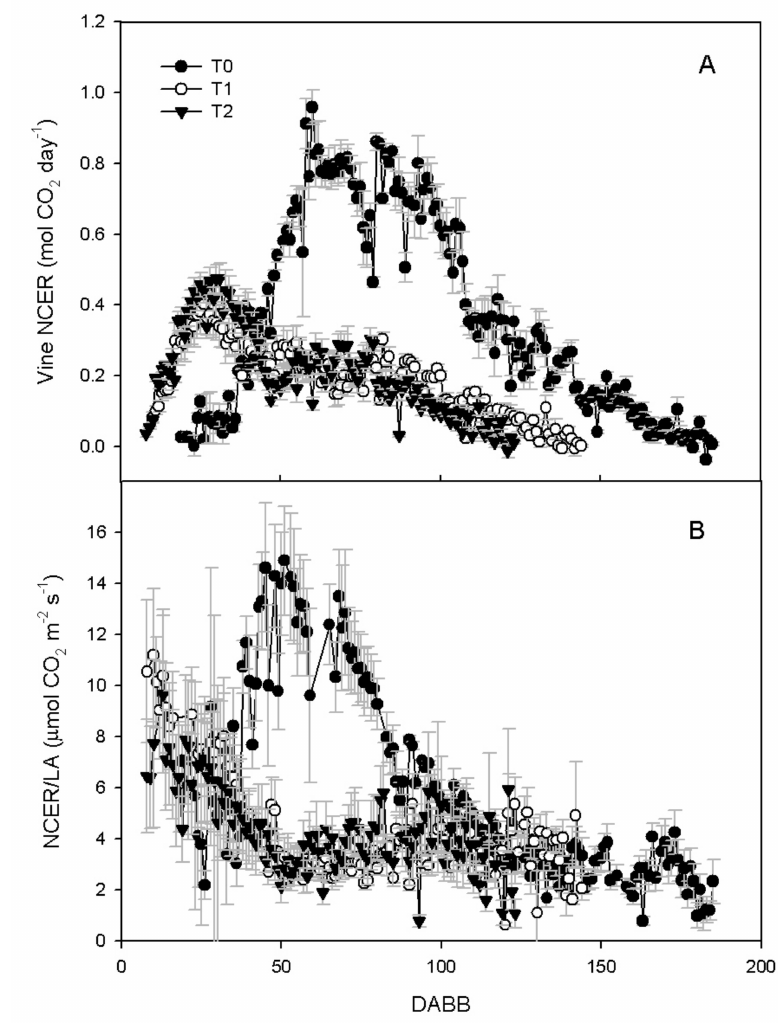
Figure 5. Vine net CO 2 exchange rate (NCER) ( A ) and daily mean leaf-specific NCER ( B ) from budburst to leaf fall vs. day after budburst (DABB) in T0, T1, and T2 vines ( n = 4). Mean ± SE. Mean daily LA-specific NCER increased in T0 until DABB 45, reaching a maximum NCER/LA of 14.61 ± 2.52 and gradually decreased over the rest of the season (Figure 5B). In T1 and T2, maximum NCER/LA was 10.36 ± 2.61 and 9.66 ± 3.07 µ mol m − 2 s − 1 , 10 and 13 DABB, respectively, and decreased sharply until 46 and 49 DABB, respectively, when it reached the minimum (2.70 ± 0.48 and 2.79 ± 0.67 µ mol m − 2 s − 1 ). After that,